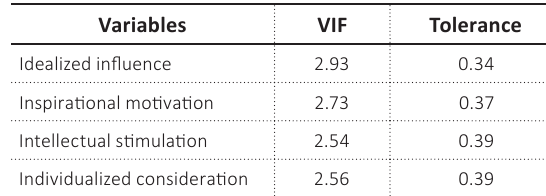
Table 2. Variation and variance